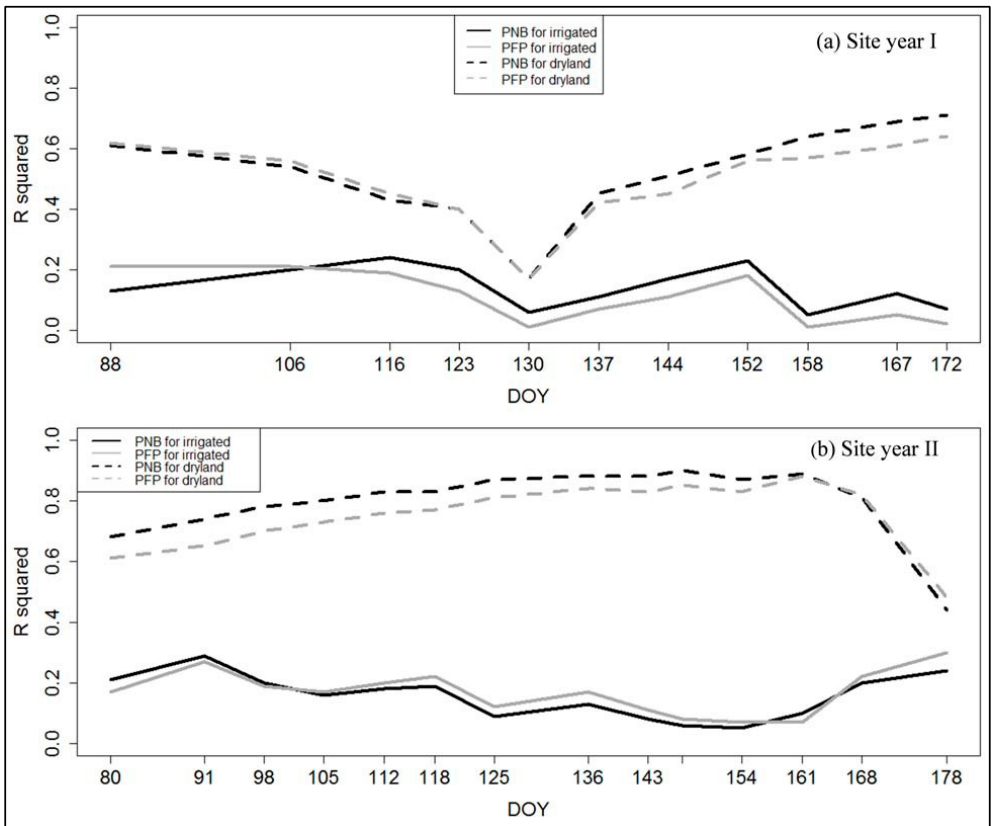
Figure 5. Relationship of the R 2 between the NDVI and PFP (partial factor productivity) and PNB (partial N balance) with the day of year (DOY) across 24 winter wheat genotypes under dryland and irrigated conditions for ( a ) site year I and ( b ) site year II.